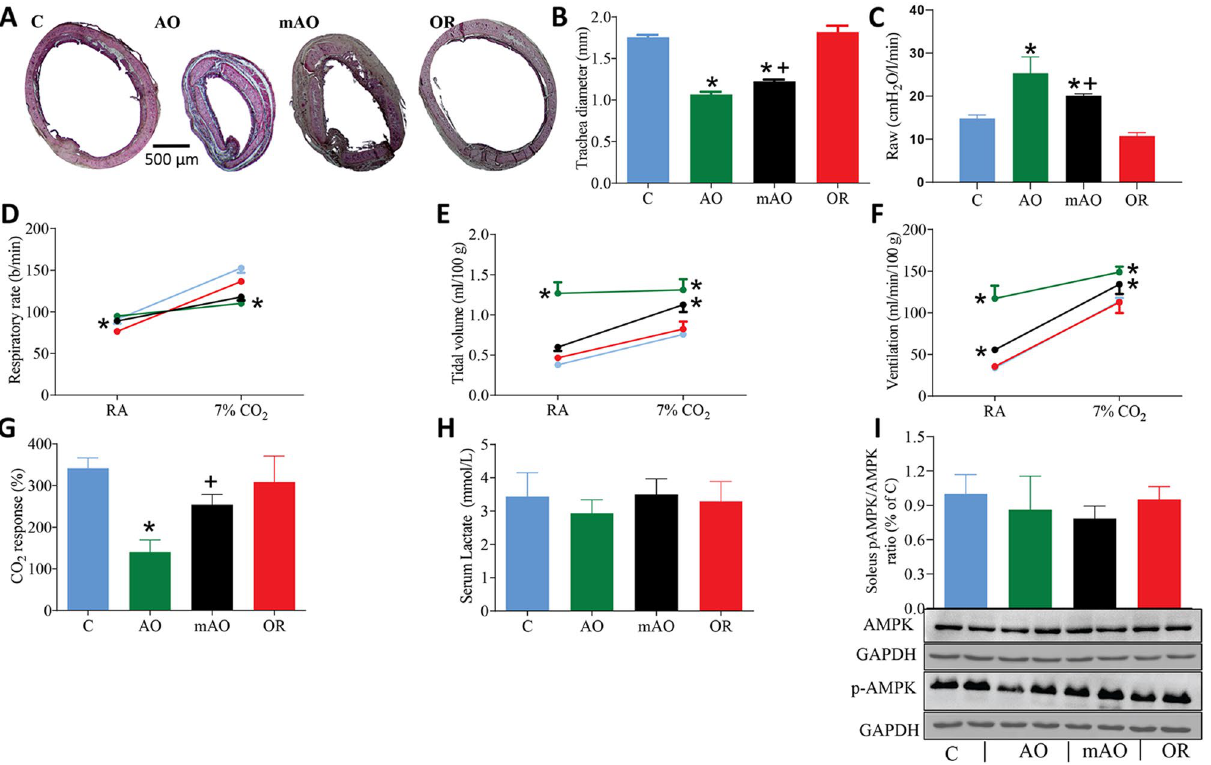
Figure 2. Respiratory activity: (A) representative image of tracheas; (B) trachea diameter; (C) airway resistance; (D) respiratory rate; (E) tidal volume; (F) minute ventilation; (G) CO 2 response calculated as the percent change in minute ventilation from room-air breathing to 7% CO 2 stimulation; (H) serum lactate level; (I) soleus p-AMPK/AMPK ratio. Raw—airway resistance; AMPK—5’ AMP-activated protein kinase; blue— control (C); green—obstructive (AO); black—mild obstructive (mAO); red—obstruction removal (OR). Values are mean ± SEM. * p < 0.01, C vs. AO or mAO group. + p < 0.05, AO vs. mAO. In (B,F–H) , statistical differences were determined by a one-way ANOVA. In (B–E) , statistical differences were determined by a two-way ANOVA, followed by a post-hoc Student–Newman–Keuls